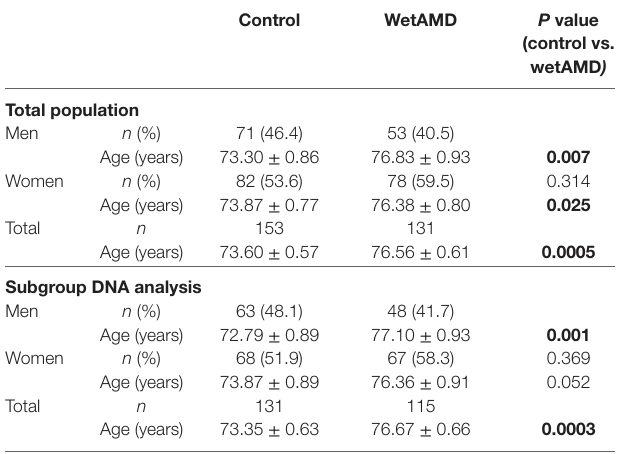
Table 1 | Demographics for the total population and the subgroup which underwent A69S genotyping analysis. control WetaMD P value (control